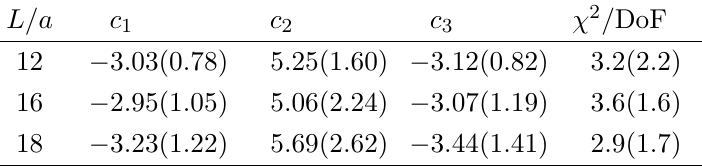
Table 6 . Fitted parameters for eq. (5.2) at each lattice size.